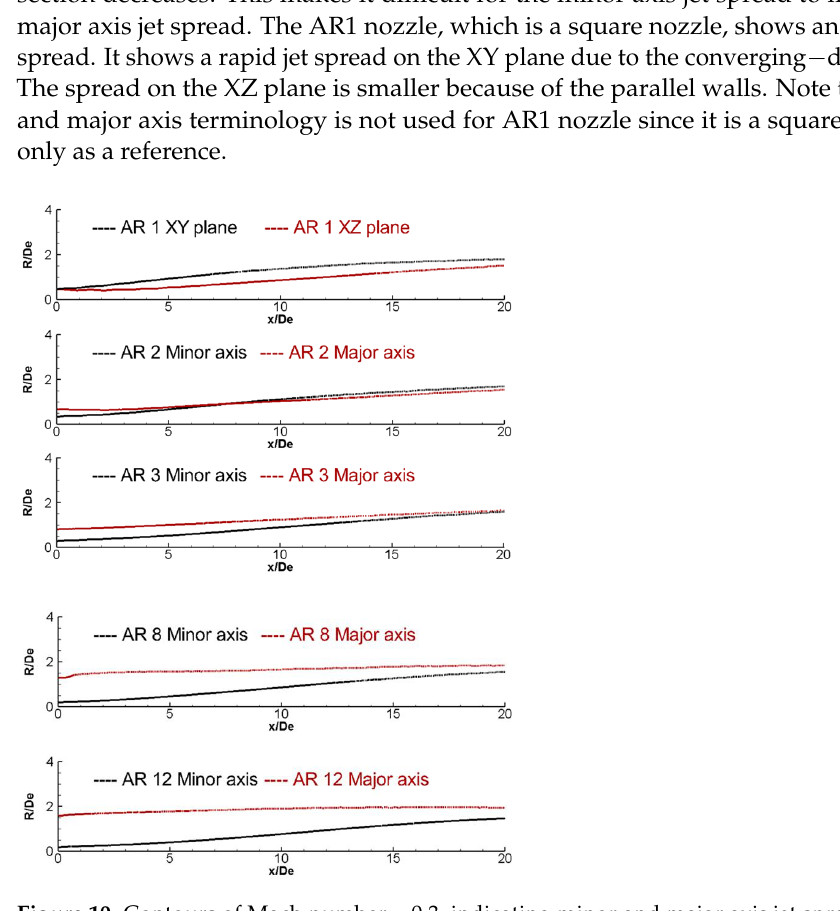
Figure 10 . Contours of Mach number = 0.3, indicating minor and major axis jet spread. Figure 10. Contours of Mach number = 0.3, indicating minor and major axis jet Figure 11 illustrates a 3D perspective of contours of axial velocity (U) normalized by the jet centerline velocity at nozzle exit (Uj) along various X-planes, starting from nozzle exit at x/De = 0 to x/De = 15. The AR2 nozzle exhibits axis switching at around 7–8 De downstream (Figure 11a), therefore, the first three crossflow planes show a memory of the nozzle cross-section, but the last three crossflow planes show a circular shape of the con- tours. For the AR3 nozzle (Figure 11b), the minor and major axis spread becomes some- what equal at ~20 x/De. The crossflow planes downstream the high AR nozzles exhibit an elliptical shape of the contours (Figure 11c,d). This means that the axis switching is de- layed or virtually nonexistent in high AR cases.